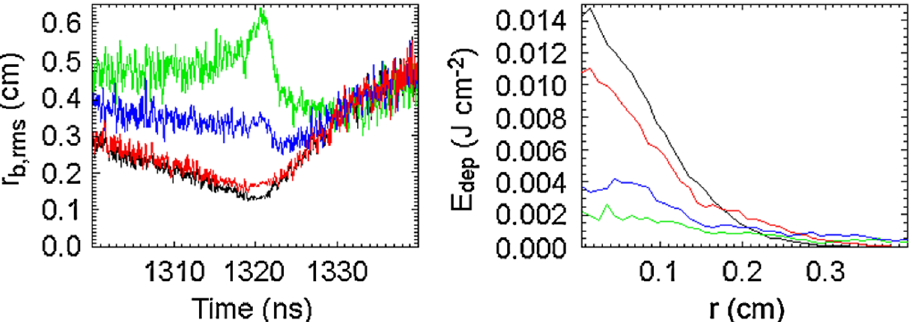
(cid:9) t (cid:10) (left) and radial profiles of cumulative E (cid:9) r (cid:10) for the main pulse from t (cid:6) b dep (cid:6) (cid:1) 32 : 3 mrad and n (cid:6) 10 10 cm (cid:1) 3 (black), 10 9 cm (cid:1) 3 (red), 10 8 cm (cid:1) 3 r p (cid:6) 0 eV . The n (cid:6) 10 11 and 10 12 cm (cid:1) 3 cases (not shown) are identical to the n p p